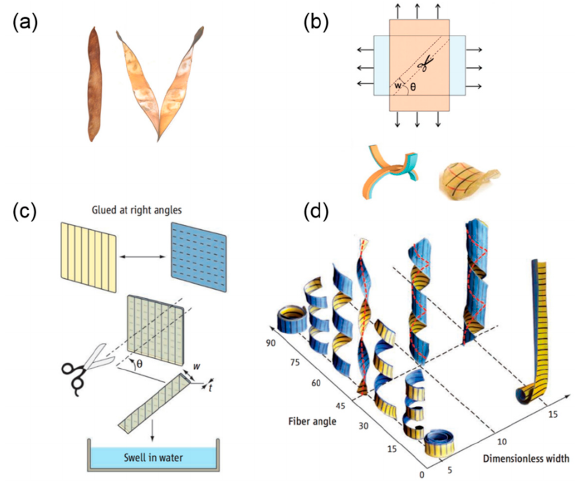
Figure 1. The opening mechanism of Bauhinia variegate ’s pod. ( a ) A closed seedpod in a wet environment (left) and the opened seedpod in a dry environment (right); ( b ) Mechanical analog of seedpod opening by attaching two uniaxially stretched elastomer sheets together and cutting a ribbon at an angle θ with width w (top). The bilayer sheet adopts a saddle shape: schematic illustration (bottom left), experiment (bottom right); ( c ) The process to generate helices using a bilayer paper sheet reinforced with fibers; ( d ) Design space for helix generation with respect to the fiber angle and the dimensionless width. ( a , b ) are from [11], reprinted with permission from AAAS; ( c , d ) are from [22], reprinted with permission from